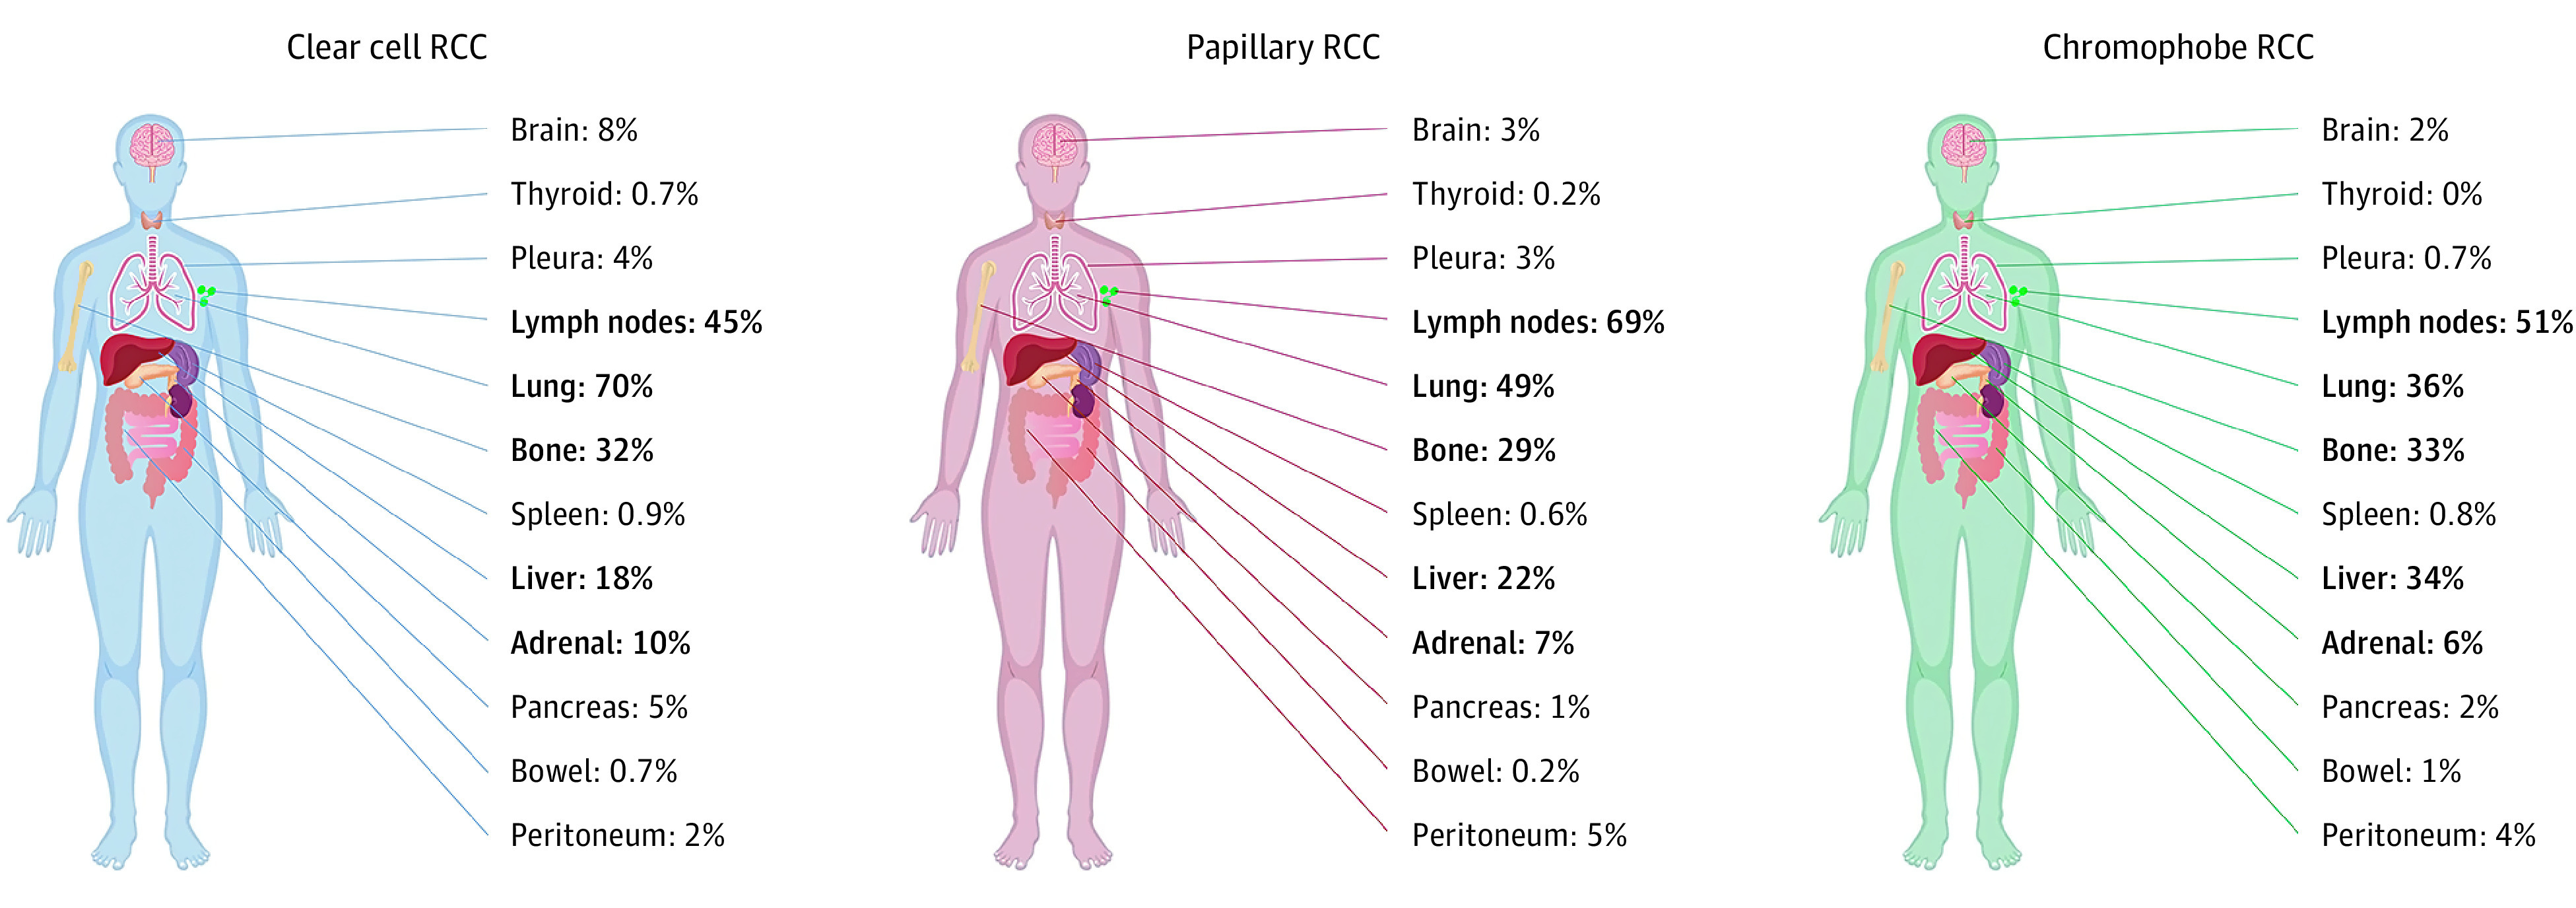
Sites of Renal Cell Carcinoma (RCC) Metastasis by Histologic SubtypeThe percentage of patients with involved site of metastasis at the time of first systemic therapy initiation for metastatic disease are presented. The 5 most frequent sites of metastasis across all histologic profiles are highlighted in bold type.